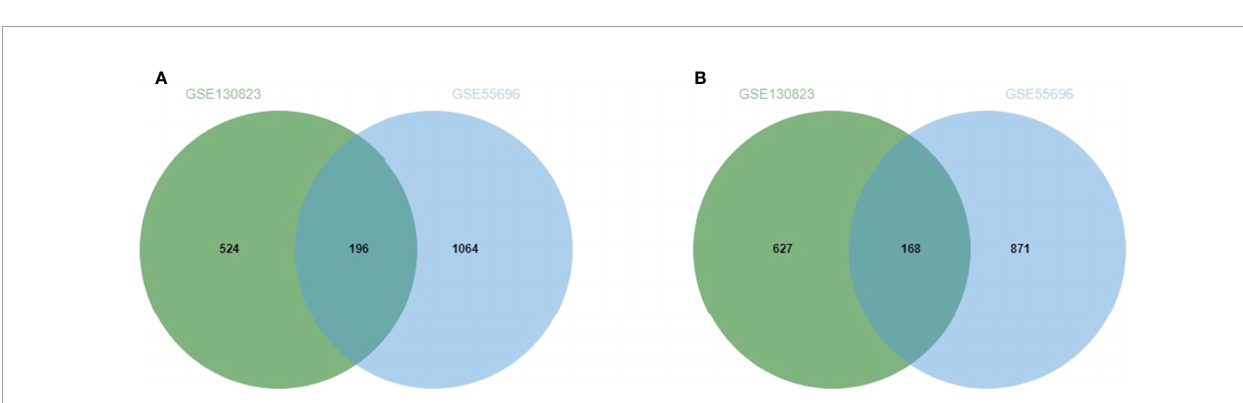
FIGURE 2 | (A) Up-regulated genes and the intersection part of the two circles is the number of DEGs intersection of dataset GSE130823 and GSE55696. (B) Down-regulated genes and the intersection part of the two circles is the number of DEGs intersection of dataset GSE130823 and